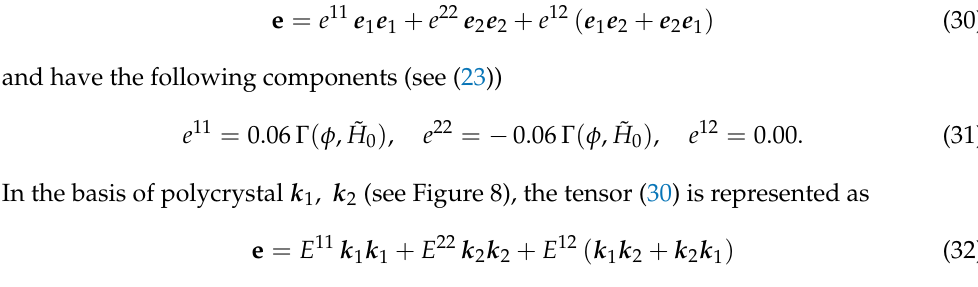
of Table 2. For this reason, the curve for an isotropic material in Figure 9 (solid blue line) consists of a series of small jumps of magnetization in the interval 0.4 If an external magnetic field is applied at an angle of 45 ◦ to vector k 1 , then, as will be shown below, detwinning does not occur in structures 1 and 2, and there are no jumps on the curves in Figure 9 (dashed lines). The magnetization curves for these textured polycrystals differ depending on the direction of the applied magnetic field because such polycrystals are